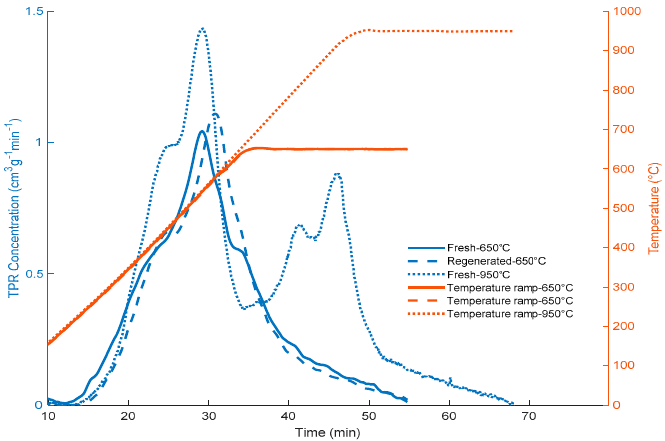
Figure 6. TPR profiles up to 650 ◦ C and 950 ◦ C for the prepared catalysts (using 10% H 2 with balanced He at a flow rate of 50 cm 3 / min and 20 ◦ C / min heating rate). Table 4. H 2 consumption for fresh and used Fe x O y /CaO- γ -Al 2 O 3 catalysts. Influence of higher TPR temperature levels.